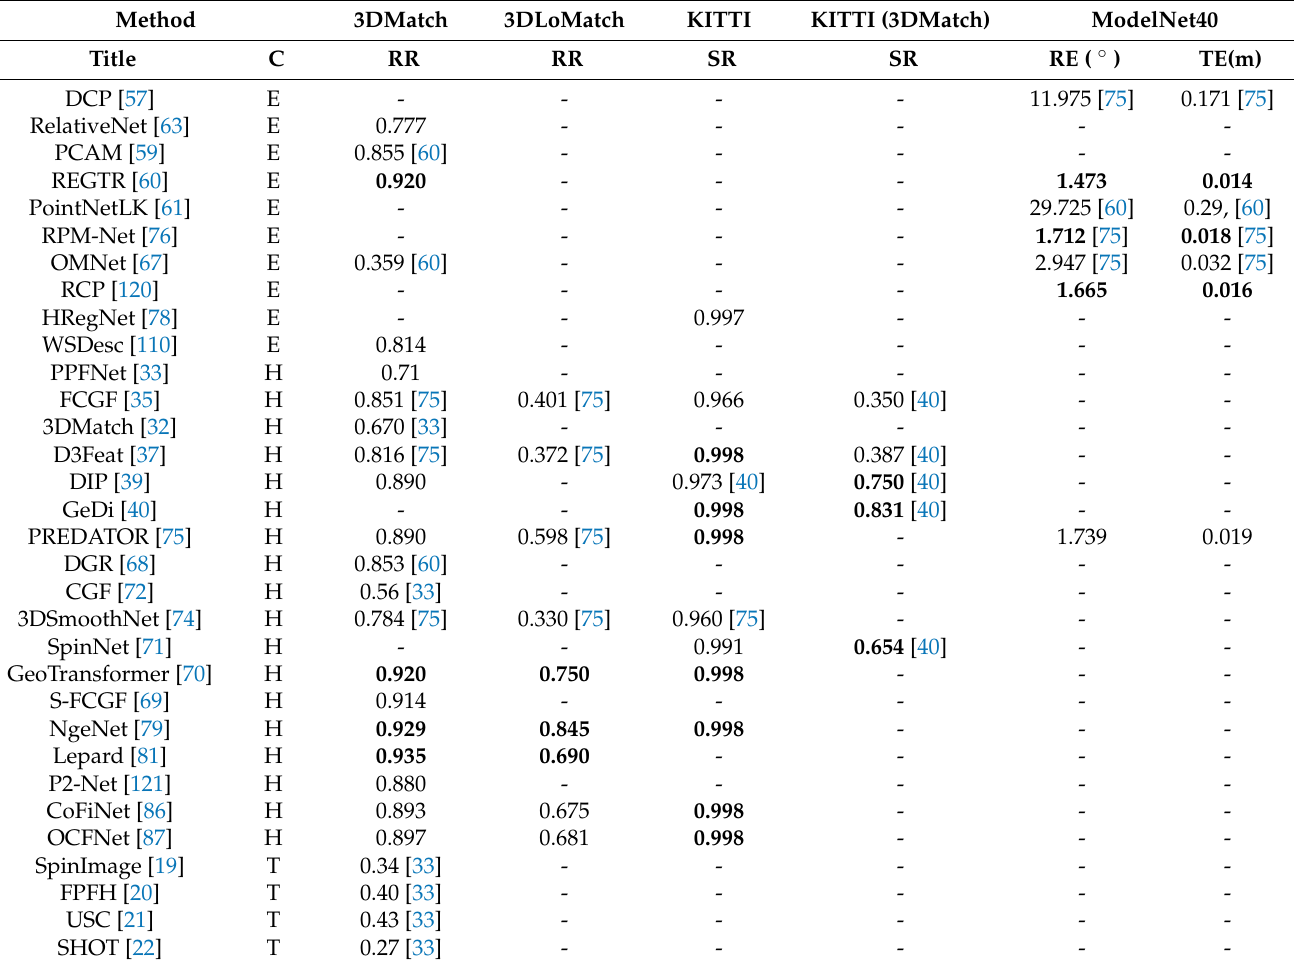
Table 3. SR, RR, RE and TE on the benchmark